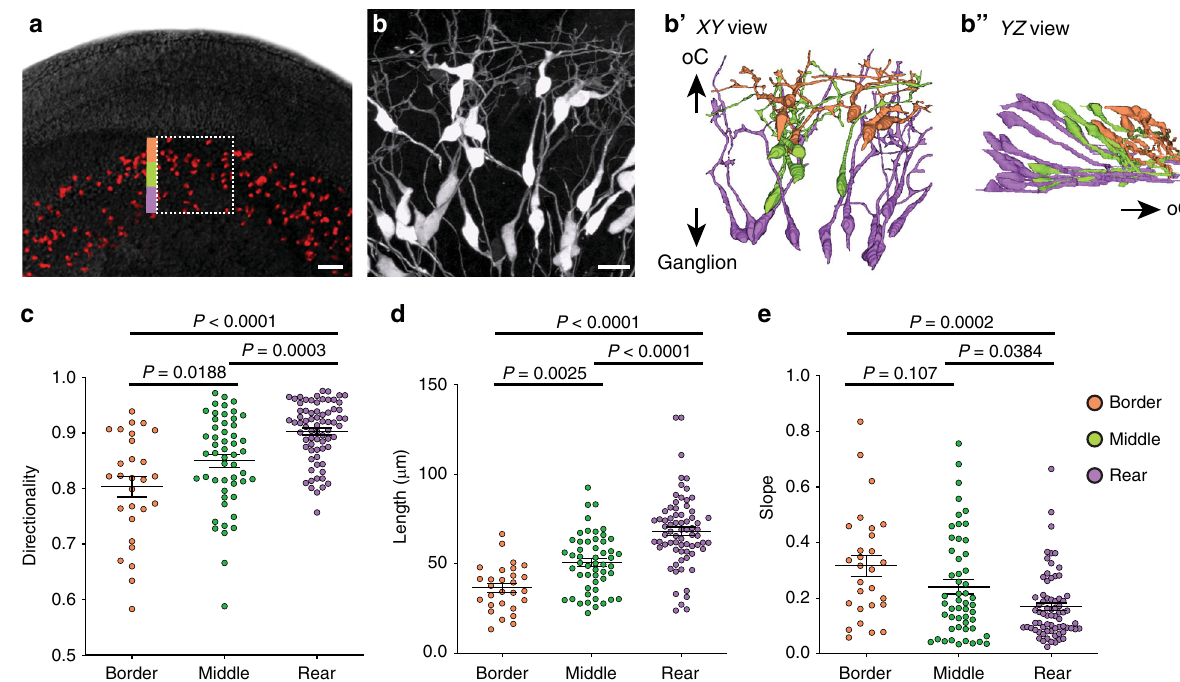
Fig. 2 SGN morphology varies with cell body position. a A top-down view of a wholemount cochlea from an E14.5 Neurog1 CreERT2 ;Ai14 animal, where a random subset of SGNs express tdTomato (red). SGN morphology was analyzed at three positions in the ganglion: close to the border (orange), in the middle (green), or in the rear (purple). b A high-power view of the boxed area in ( a ), with reconstructions of individual SGNs shown in ( b ′ ) (XY view) and ( b ″ ) (YZ view). SGNs are color-coded according to the position of their cell body. 7 cochleae were stained and analyzed (see Supp. Figs. 1 and 2). c – e Quanti fi cation of SGN morphology. Border cells ( n = 28) (orange dots) extend processes that are less directional ( c ), shorter ( d ), and have a greater slope ( e ) than rear cells ( n = 71). Middle cells ( n = 52) exhibit intermediate morphologies. Plots show raw data with means ± SEM superimposed. Directionality: border cells: 0.803 ± 0.012; middle cells: 0.850 ± 0.011; rear cells: 0.903 ± 0.006. Length: border cells: 36.68 ± 2.433; middle cells: 50.88 ± 2.247; rear cells: 68.22 ± 2.418. Slope: border cells: 0.316 ± 0.037; middle cells: 0.240 ± 0.026; rear cells: 0.168 ± 0.014. Signi fi cance was assessed using ANOVA with Tukey ’ s multiple comparison test. Directionality: border vs middle, P = 0.188; middle vs rear, P = 0.0003; border vs rear, P < 0.0001. Length: border vs middle, P = 0.0025; middle vs rear, P < 0.0001; border vs rear, P < 0.0001. Slope: border vs middle, P = 0.107; middle vs rear, P = 0.0384; border vs rear, P = 0.0002. Source data are provided as a Source data fi le. Scale bars: 50 µ m ( a ) and 25 µ m ( b ). See Supplementary Movie